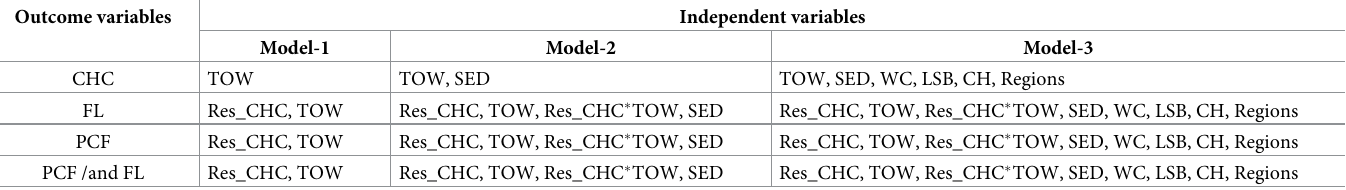
Table 1. Description of logistic regression